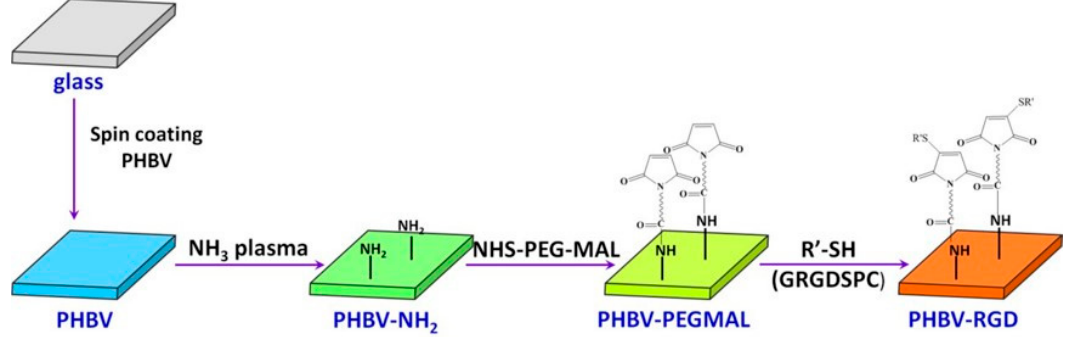
Figure 12. Preparation and surface modification of PHBHV film. Reprinted with permission from [151]. Copyright 2011 American Chemical Society.